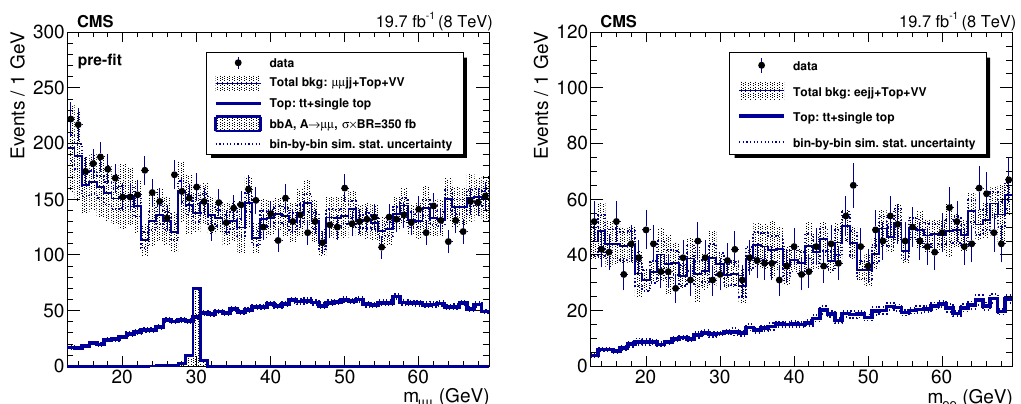
Figure 3 . Left: the dimuon mass distribution with the pre-(cid:12)t expected background event yield and its uncertainty, and the expected signal for m A = 30 GeV assuming a signal cross section times branching fraction of 350 fb. Right: cross-check with the e + e (cid:0) (cid:12)nal state showing the dielectron mass spectrum with the expected background event yield and its